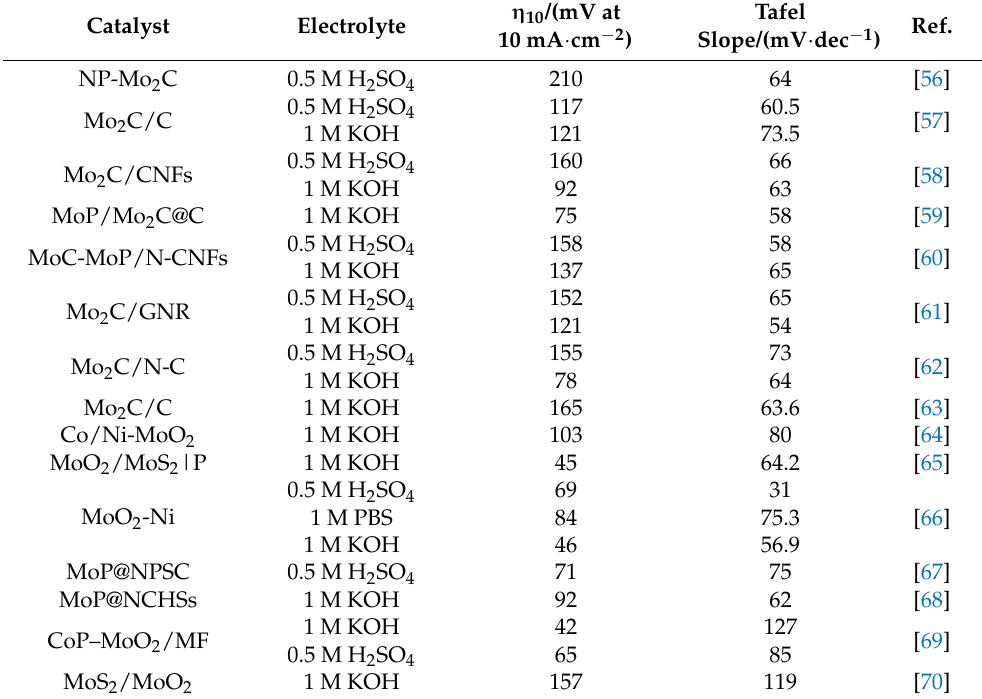
Table 1. Summary of the representative Mo based electrocatalysts for hydrogen evolution reaction.